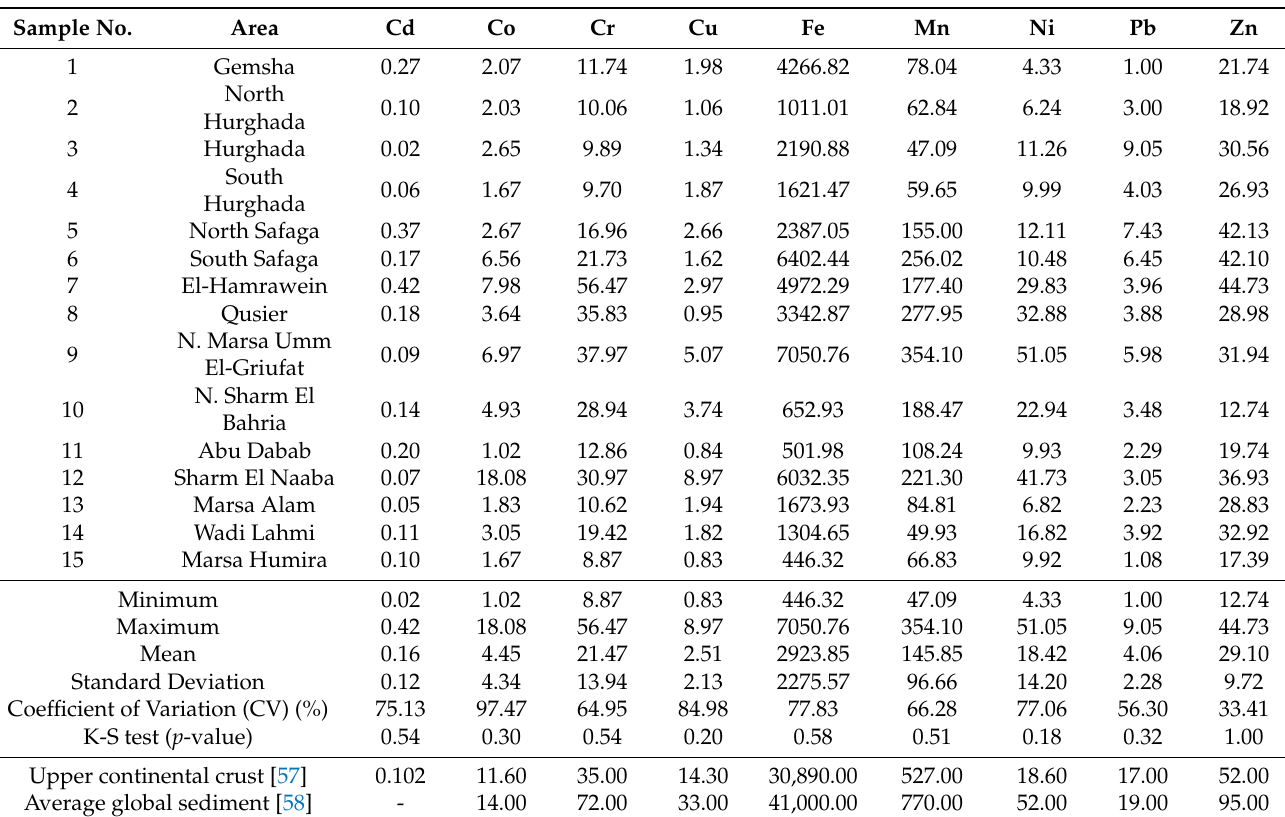
Table 3. Descriptive statistics of PTEs (ppm) in Red Sea